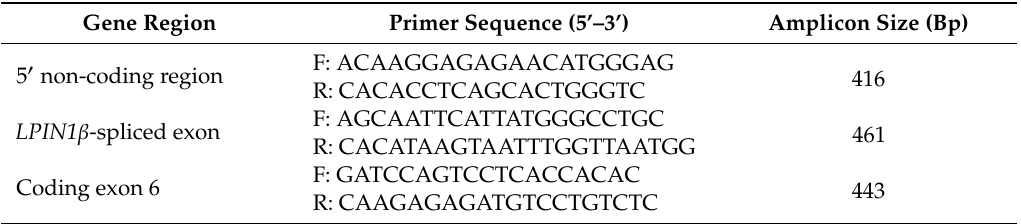
Table 1. Polymerase Chain Reaction (PCR) primers used for amplification of three regions of ovine LPIN1